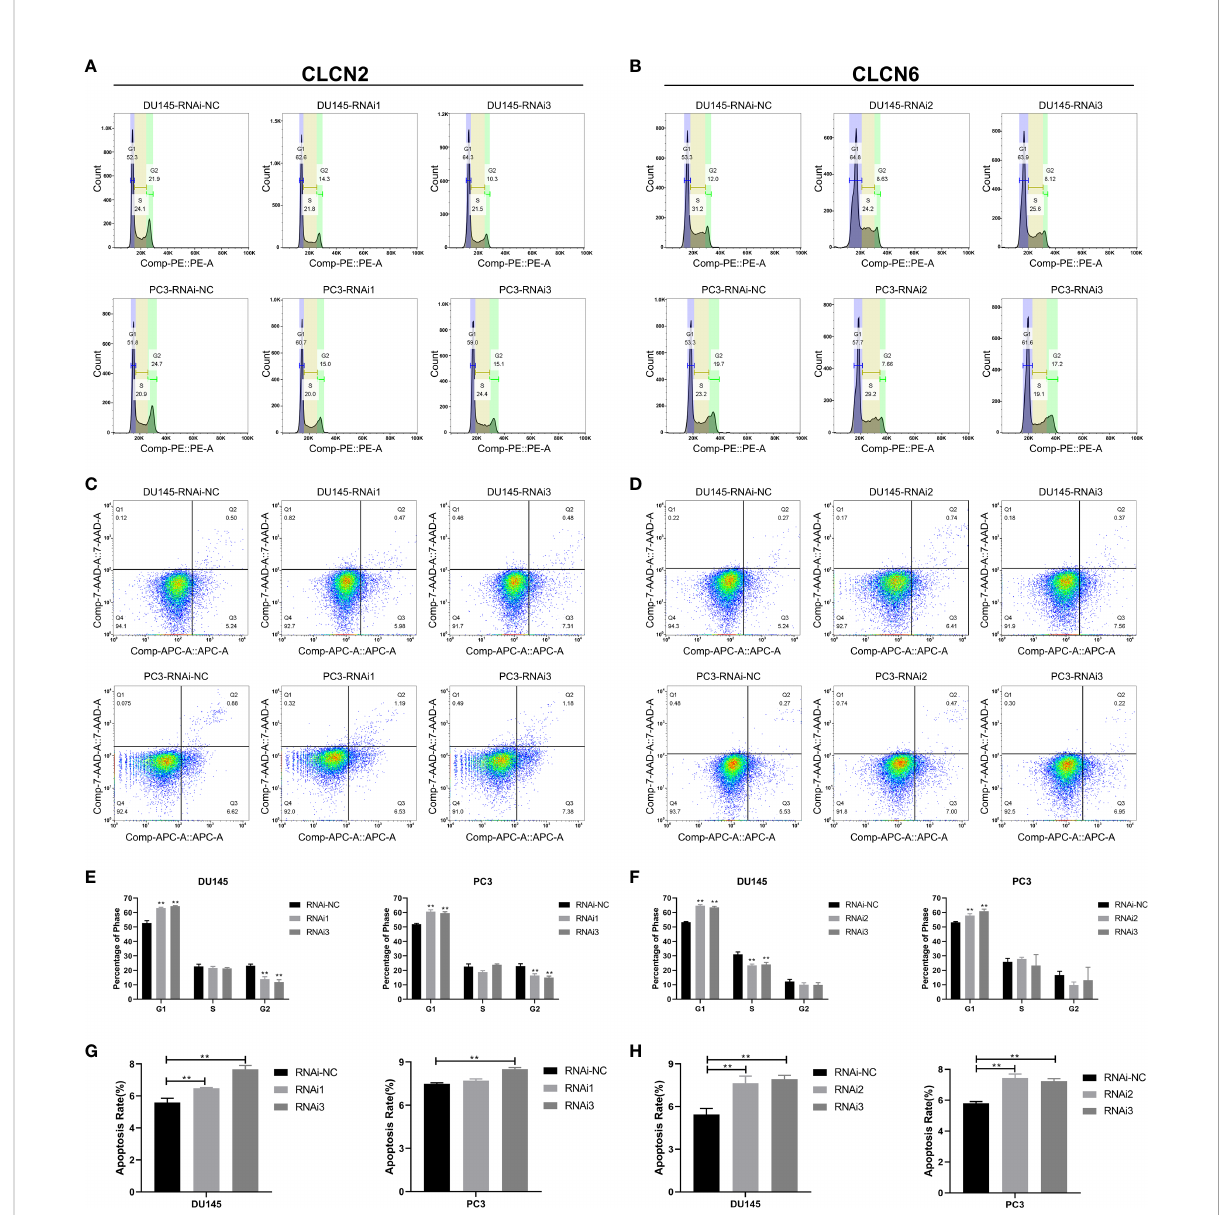
FIGURE 12 Downregulation of CLCN2 or CLCN6 prolonged cell cycle and promoted apoptosis. Downregulation of (A, E) CLCN2 or (B, F) CLCN6 could prolong cell cycle progression. Downregulation of (C, G) CLCN2 or (D, H) CLCN6 increased apoptosis. **